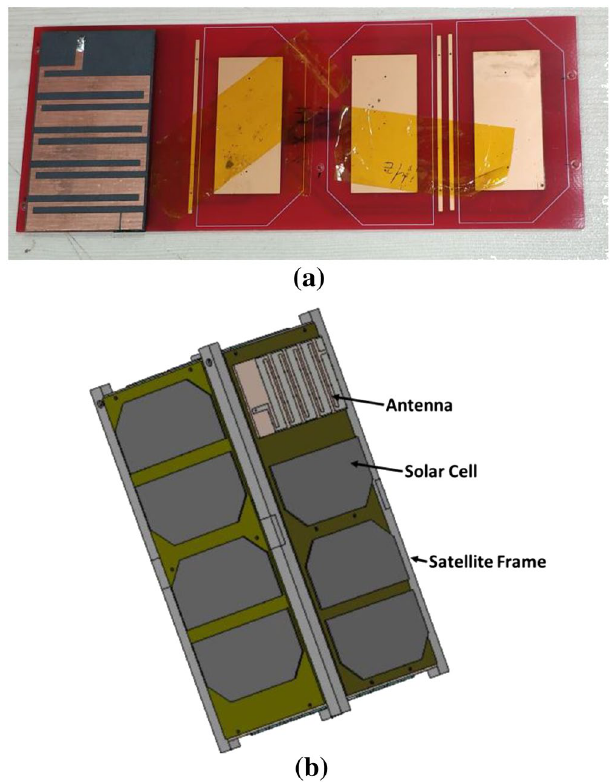
Figure 9. Optimized antenna mounted on 2U Cube satellite body in ( a ) fabricated structure and ( b ) simulation environment.